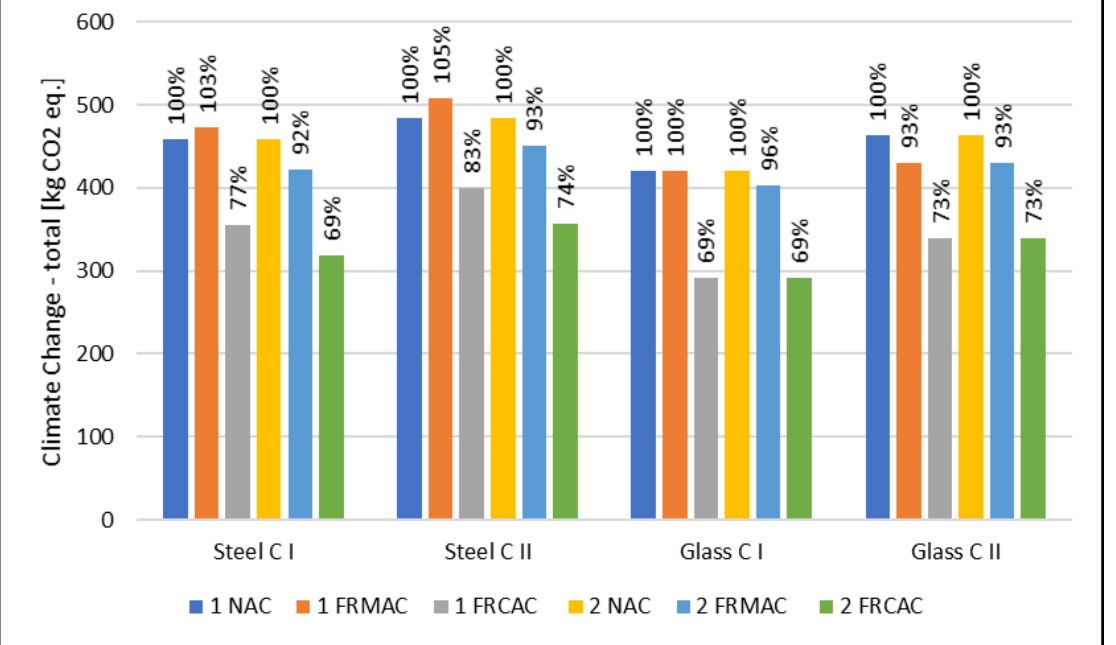
Figure 4. Results of climate change for concrete slab designed according to the load-bearing capacity limit state. (1) The compensation by varying thickness of slab; (2) the compensation by varying reinforcement level.